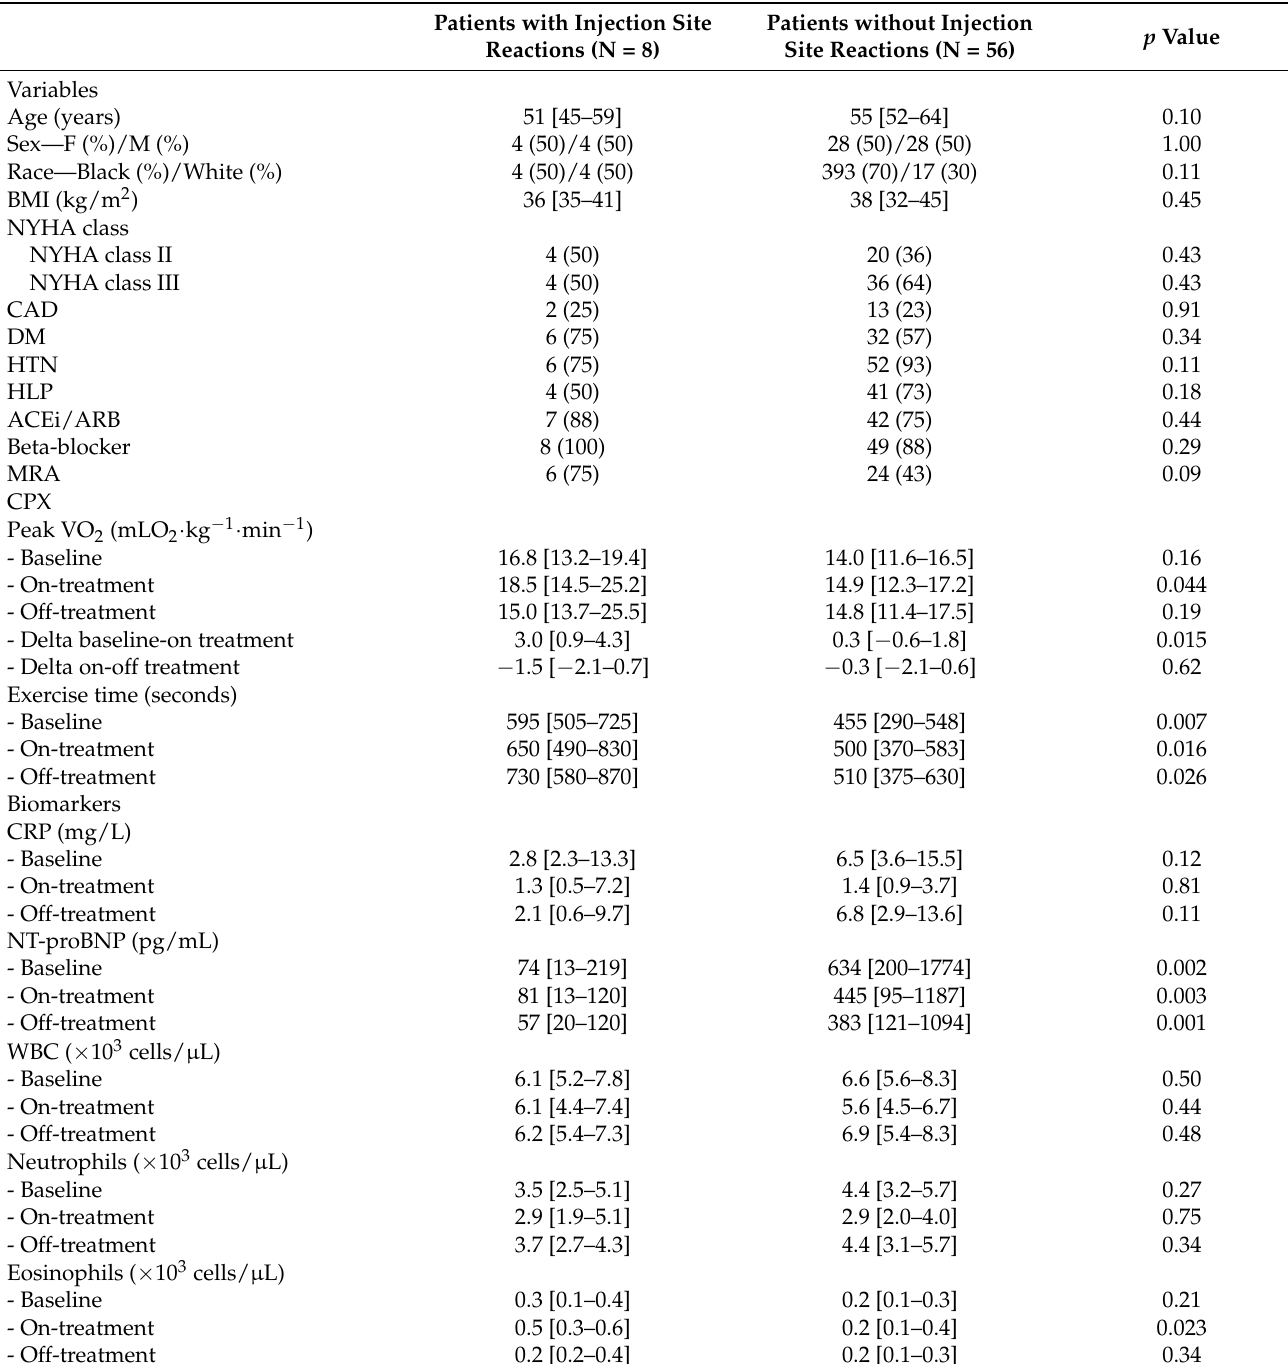
Table 3. Clinical characteristics, cardiorespiratory fitness, and biomarkers in patients with and without injection site